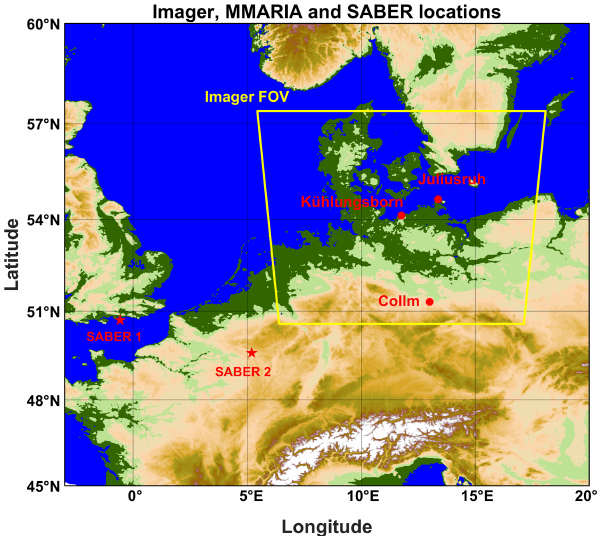
Figure 1. The map of northern Europe where it shows the lo- cation of the multiwavelength airglow imager at Kühlungsborn, MMARIA transmitter stations (Collm and Juliusruh), and receiver stations (Juliusruh and Kühlungsborn). The map has been gener- ated from ETOPO1 1 Arc-Minute Global Relief Model (Amante and Eakins, 2009). The yellow box is the maximum horizontal cov- erage of the airglow imager in the MLT region. The red asterisks show the SABER temperature measurement